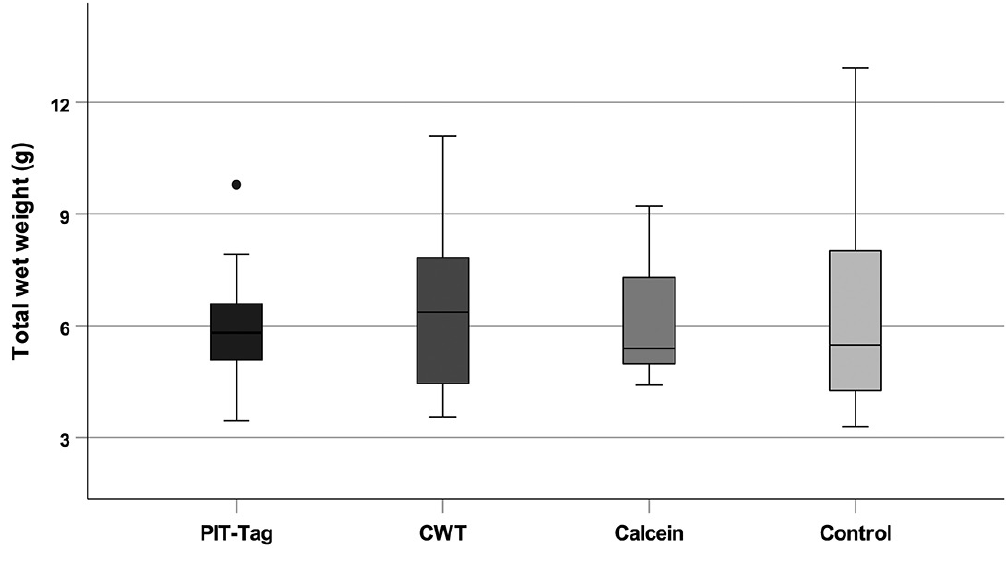
Fig. A2. – Boxplot representing the initial total wet weight of Paracentrotus lividus at the beginning (T1) of a 60-day rearing in the laboratory using PIT-tags, coded wire tags (CWTs), calcein and an untagged control. The boxplot represents the minimum, maximum, median, first quartile and third quartile of the data set and the dot represents an